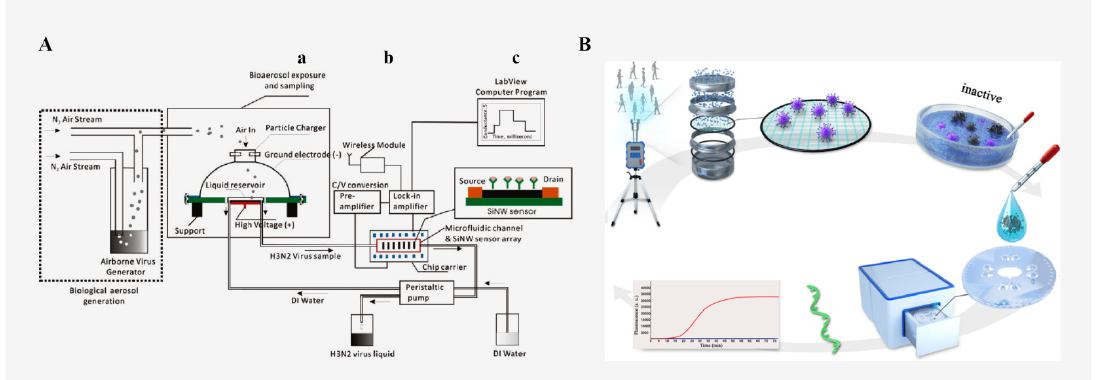
Figure 4. ( A ) Micro-optofluidic platform for the real-time, continuous detection of airborne microorganisms. (a) bioaerosol sampling and delivery, (b) antibody modified silicon nanowire based biosensor, and (c) signal amplification, detection, and online monitoring Reproduced with permission from ref. [101]. Copyright 2011 American Chemical Society. ( B ) Schematic diagram of the SARS-CoV-2 integrated sampling/monitoring microfluidic platform. Reproduced with permission from ref. [103]. Copyright 2021 American Chemical Society.